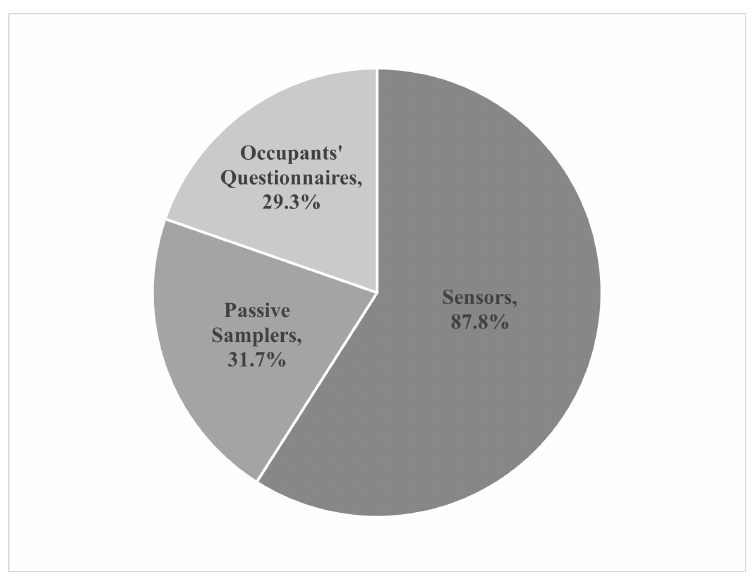
Figure 8. Measuring methods used in the examined field measurement studies.